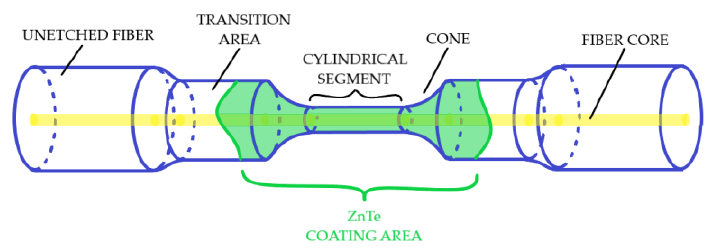
Figure 2. Scheme of a thinned section of a fiber light guide.